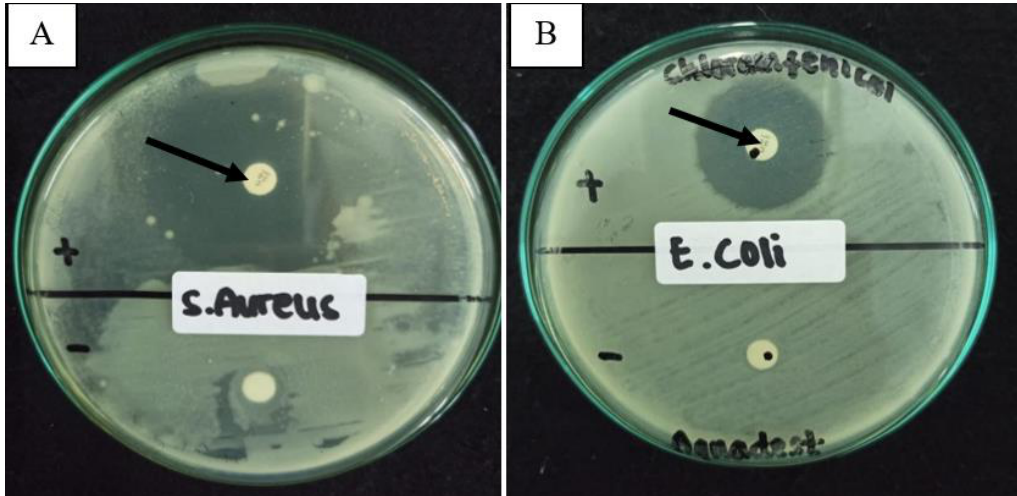
Figure 5: Test results for (a) Staphylococcus aureus and (b) Escherichia coli bacteria, where positive control used chloramphenicol antibiotic discs with a concentration of 30 and negative controls employed aquadest. The black arrow indicates the inhibition zone in the positive control test with the chloramphenicol used against both